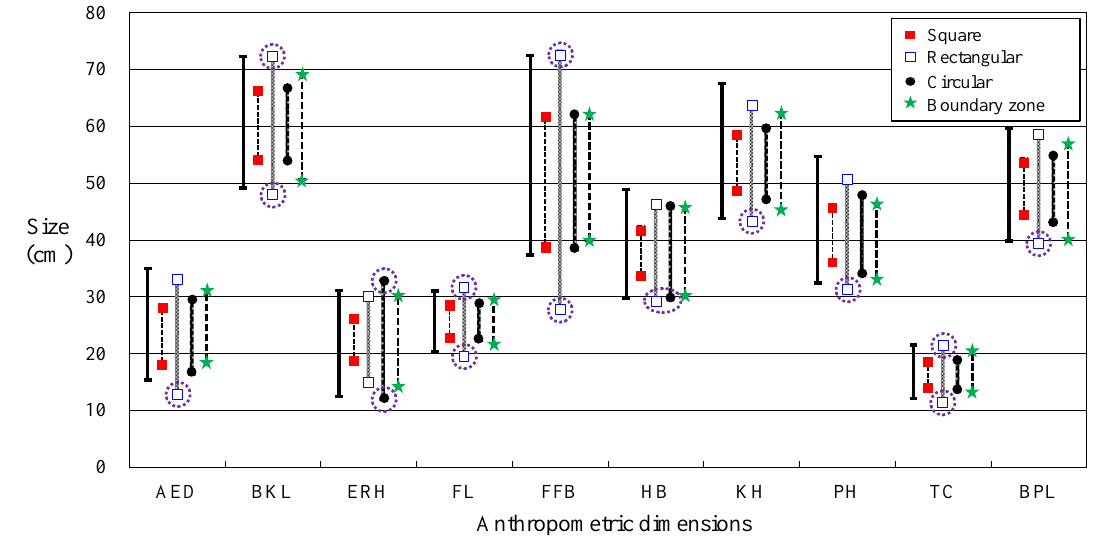
Figure 6. Occurrence of improper representative humanoids (highlighted in dotted circles) beyond the body size ranges of the target population. AED, abdominal extension depth; BKL, buttock–knee length; ERH, elbow-rest height; FL, foot length; FFB, forearm-to-forearm breadth; HB, hip breadth; KH, knee height; PH, popliteal height; TC, thigh clearance; BPL, buttock–popliteal length.